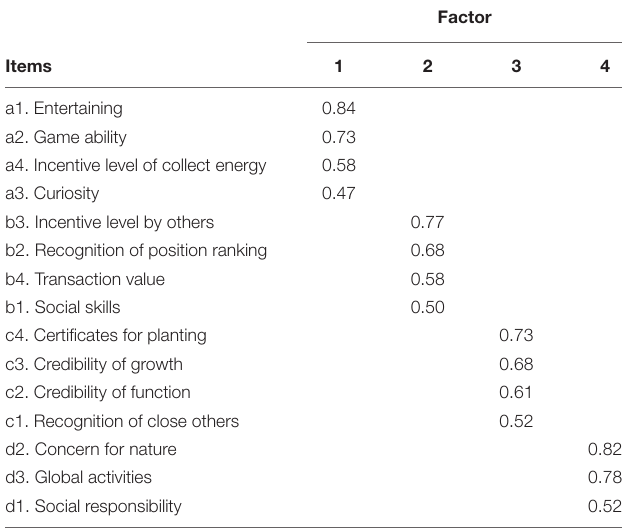
TABLE 1 | Factor loadings for the items in the